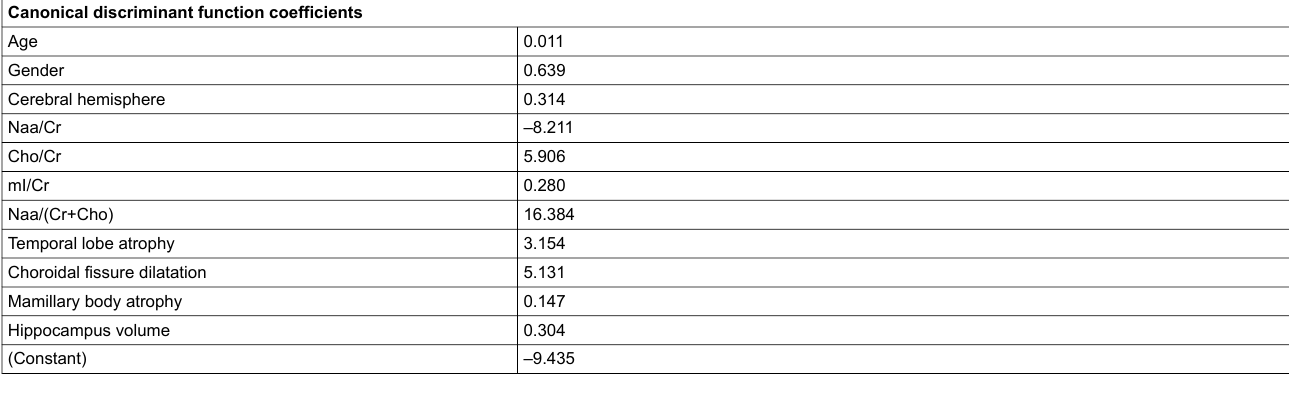
Table 5: Means of the predictor variables (centroids) used to describe each group in terms of its profile. The cut-off value is considered the mean of the two centroids; if the discriminant score of the function is less than or equal to the cut-off a new case can be classed as 0 (absent MTS), whereas if it is above, it is classed as 1 (present MTS). Diagnosis of